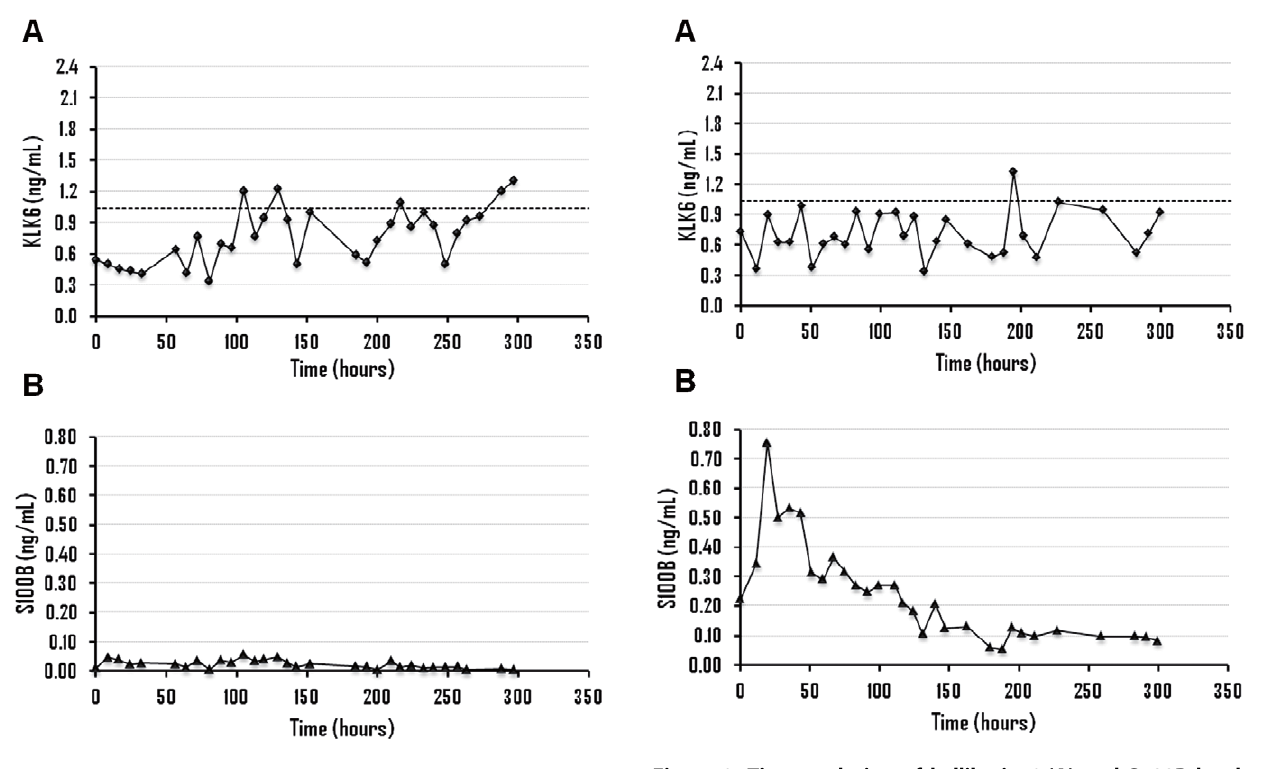
Figure 2. Time evolution of kallikrein 6 (A) and S100B levels (B), in ng/mL, for patient 8.